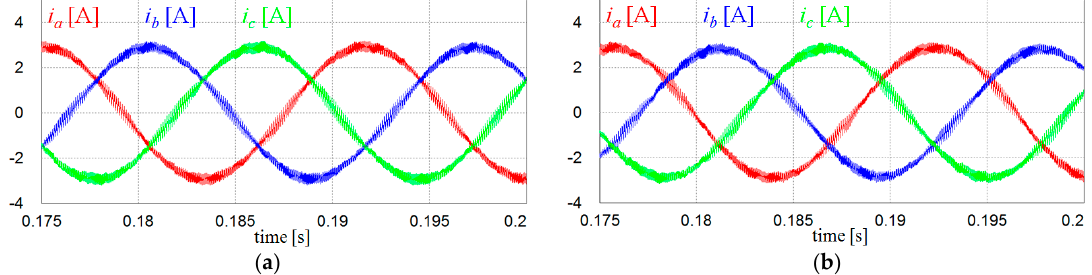
Figure 10. Comparison of inverter output currents under unbalanced grid condition. ( a ) Inverter output currents with voltage measurements; and ( b ) inverter output currents with the proposed voltage-sensorless control.